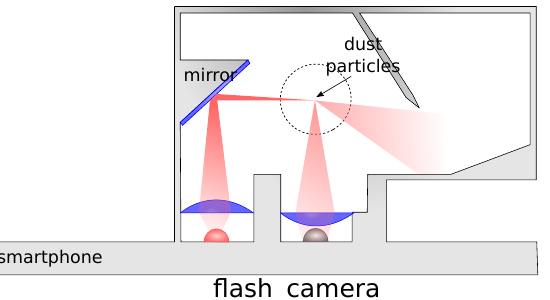
Figure 3. Custom light trap design with a mirror to relay the light from the flash LED into the measurement